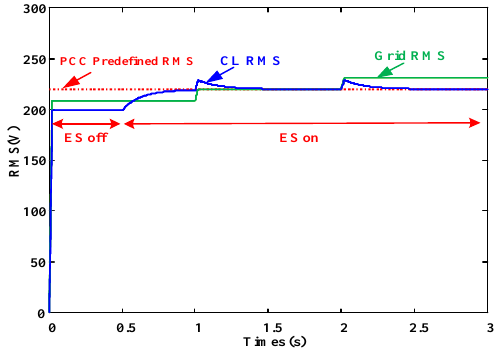
Figure 9. Simulation results of voltage control for a single ES.